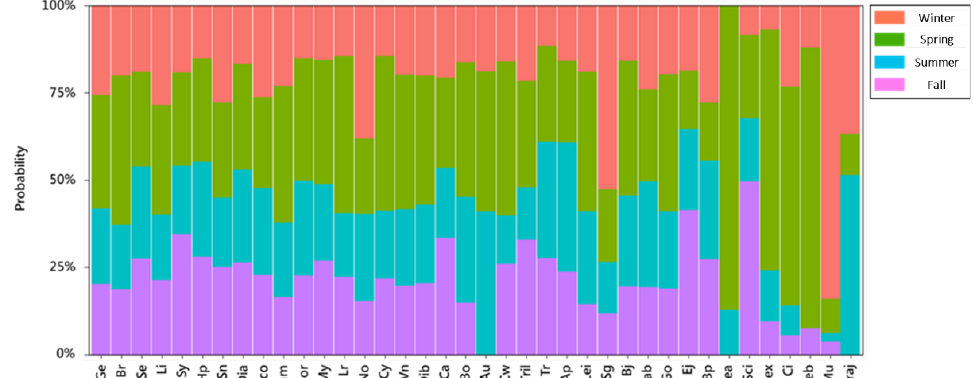
Figure 4. Analytical results of the occurrence probability of larvae and juveniles of individual fish species in different seasons around Taiwan (2007 – 2019). The fish codes are defined as follows: Trachurus japonicus as Traj, Engraulis japonicus as Ej, Trichiurus spp. as Tril, Synagrops spp. as Sy, Auxis spp. as Au, Decapterus macrosoma as Dea, Bramidae spp. as Br, Gempylidae spp. as Ge, Decapterus spp. as Dex, Decapterus maruadsi as Deb, Mugilidae spp. as Mu, Clupeidae spp. as Cl, Benthosema pterotum as Bp, Ceratoscopelus warmingi as Cw, Cyclothone alba as Cy, Lestrolepis spp. as Lr, Vinciguerria nimbaria as Vn, Myctophum orientale as Mor, Hygophum proximum as Hp, Stomias nebulosus as Sn, Lampanyctus spp. as Lam, Bregmaceros spp. as Bj, Myctophidae spp. as My, Diaphus A group as Dia, Diaphus B group as Dib, Serranidae spp. as Se, Sigmops gracilis as Sg, Trachinocephalus myops as Tr, Notosudidae spp. as No, Apogonidae spp. as Ap, Labridae spp. as Lab, Callionymidae spp. as Ca, Lestidium as Li, Bothidae spp. as Bo, Scorpaenidae spp. as Sco, Leiognathidae spp. as Lei, Gobiidae spp. as Go, and Sciaenidae spp. as Sci.